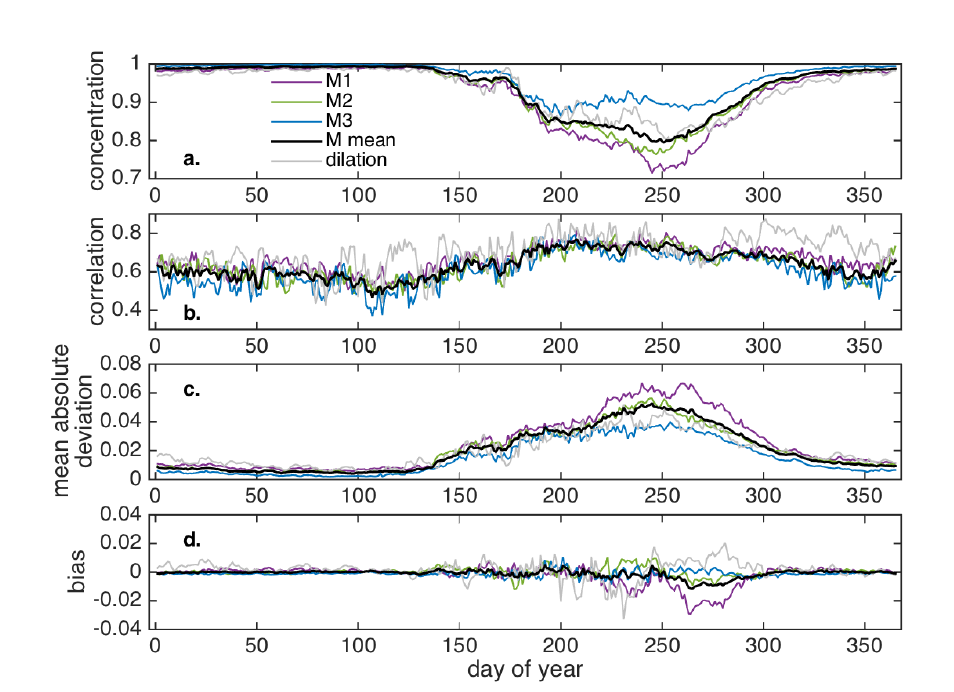
Figure 5. For each of the regions M1–M3 in Figure 1, color curves indicate values averaged by day of the year: ( a ) mean observed sea ice concentration; ( b ) spatial correlation between observed sea ice concentration and the solution to Laplace’s equation ψ ; ( c ) the mean absolute deviation between observed sea ice concentration and ψ ; and ( d ) the spatially averaged bias between observed sea ice concentration and ψ . In each panel, the black curve is the average across the three M regions and the gray curve corresponds to validation via dilation of the polar data gap as described in Section